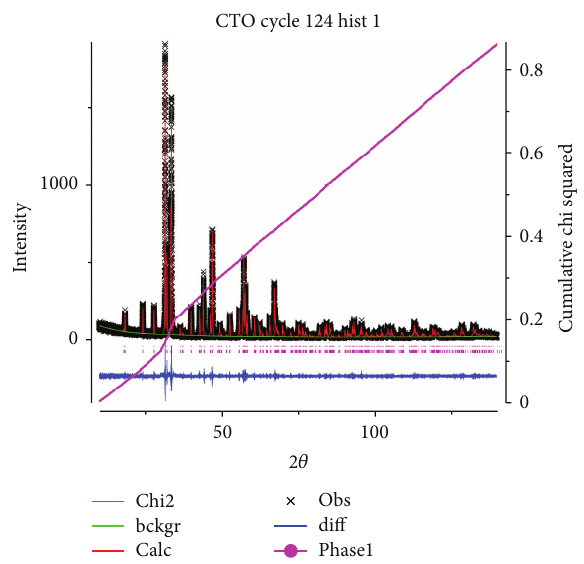
Figure 3: Rietveld refinement plot of Cd 2 SnO 4 .